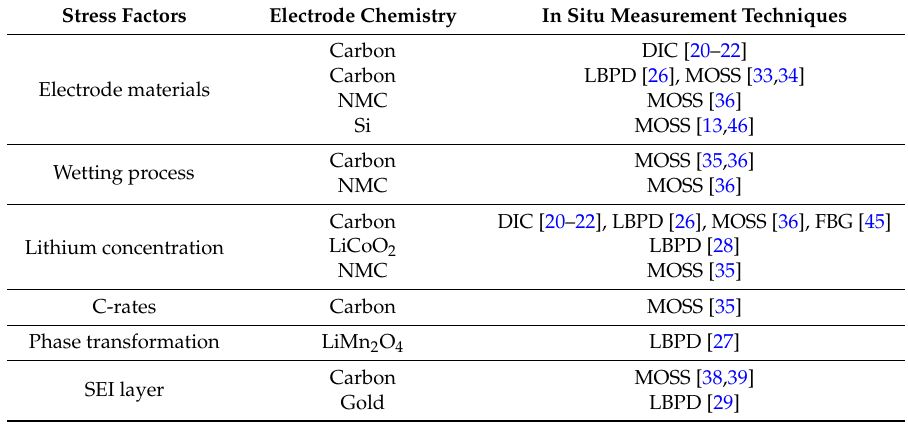
Investigation of influences on electrode stress generation and evolution. nickel cobalt manganese.